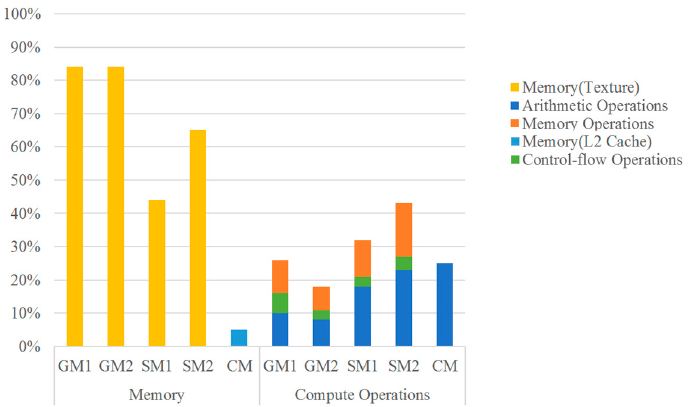
Figure 8. Distribution of memory usage and computing operations for different implementations.